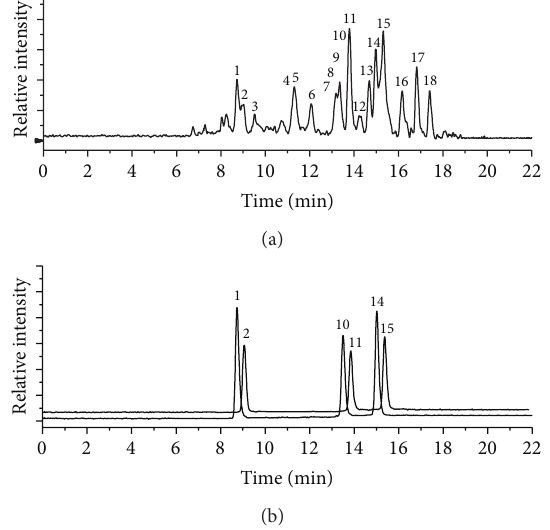
Figure 1: (a) Total ion chromatogram of the purified flavonoid extract from Juglans regia L. leaves and (b) total ion chromatogram ofthemixtureofreferencesubstances.PeaknumbersrefertoTable